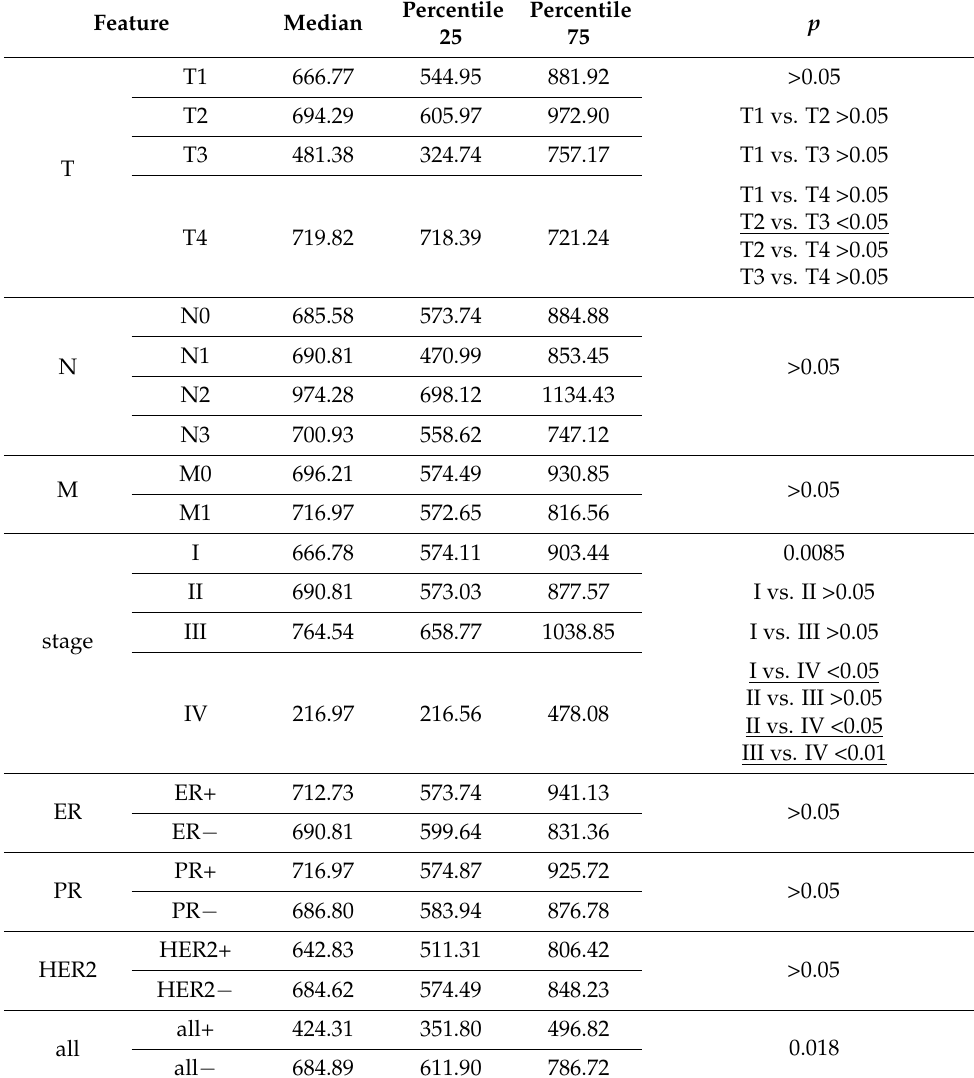
Table 7. Expression of uc.38 in breast cancer patients depending on clinical-pathological